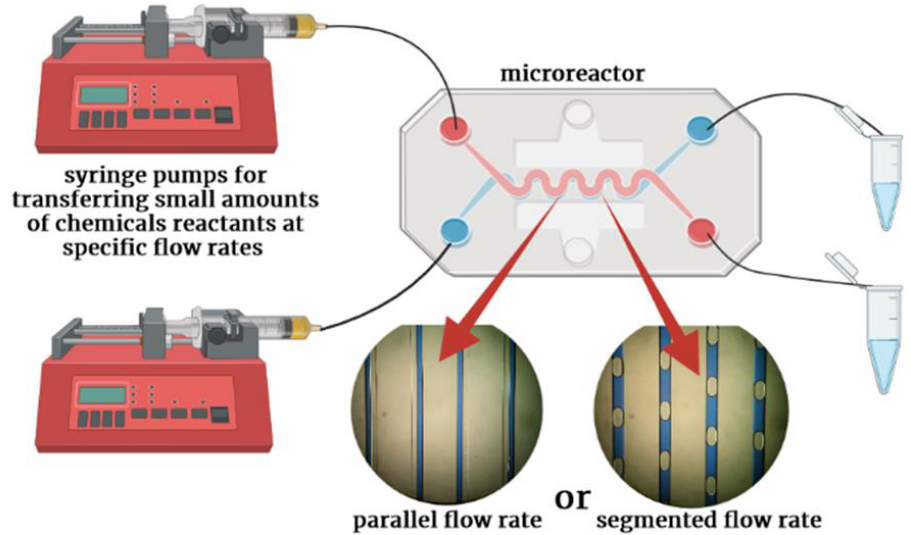
Figure 1. Example of a simple microfluidic setup (Created in BioRender.com).